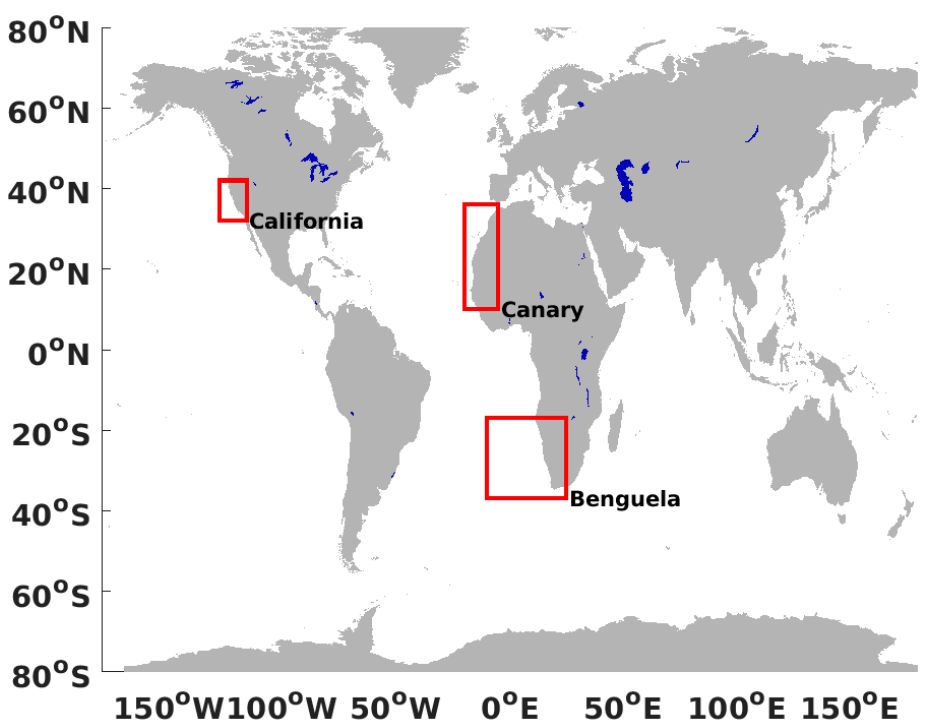
Figure A1. The three EBUS zones of interest: California, Canary, and Benguela are shown as red rectangles.